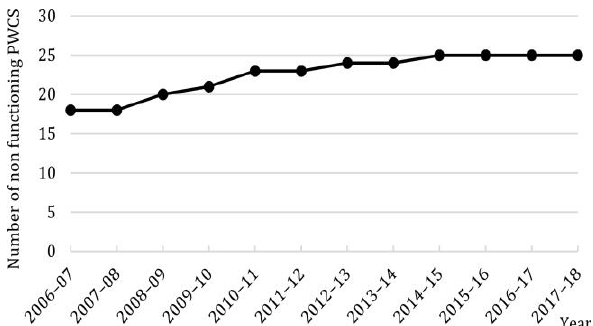
Fig. 9. Year wise number of non functioning PWCS (Tarakeswar zone) (Source: Handloom Development Office, Chinsurah, 2018)